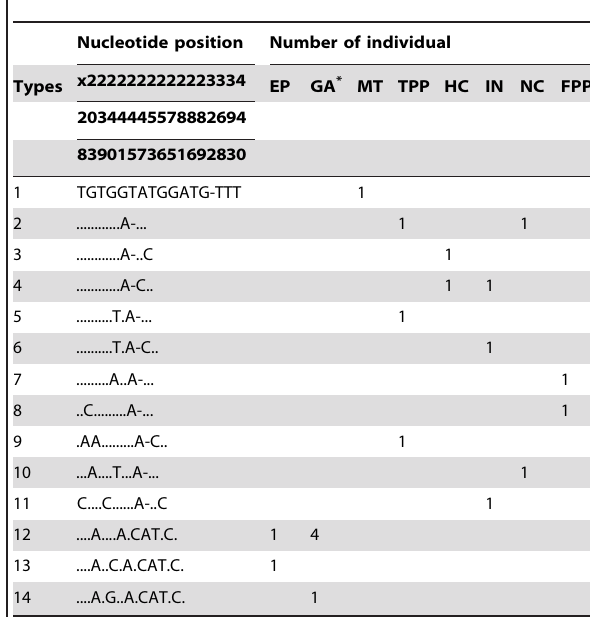
Table 3. Polymorphic nucleotide sites in 535 bp partial mitochondrial DNA 16S rRNA gene of 14 haplotypes detected in 20 individuals of Panulirus penicillatus